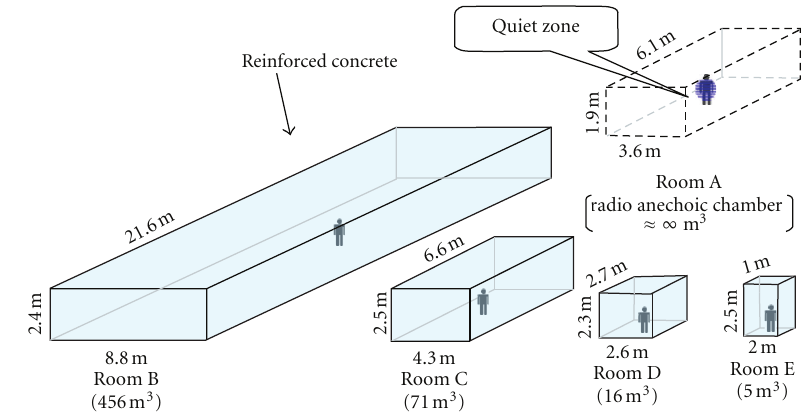
Figure 1: The outline of five rooms used for experiments.